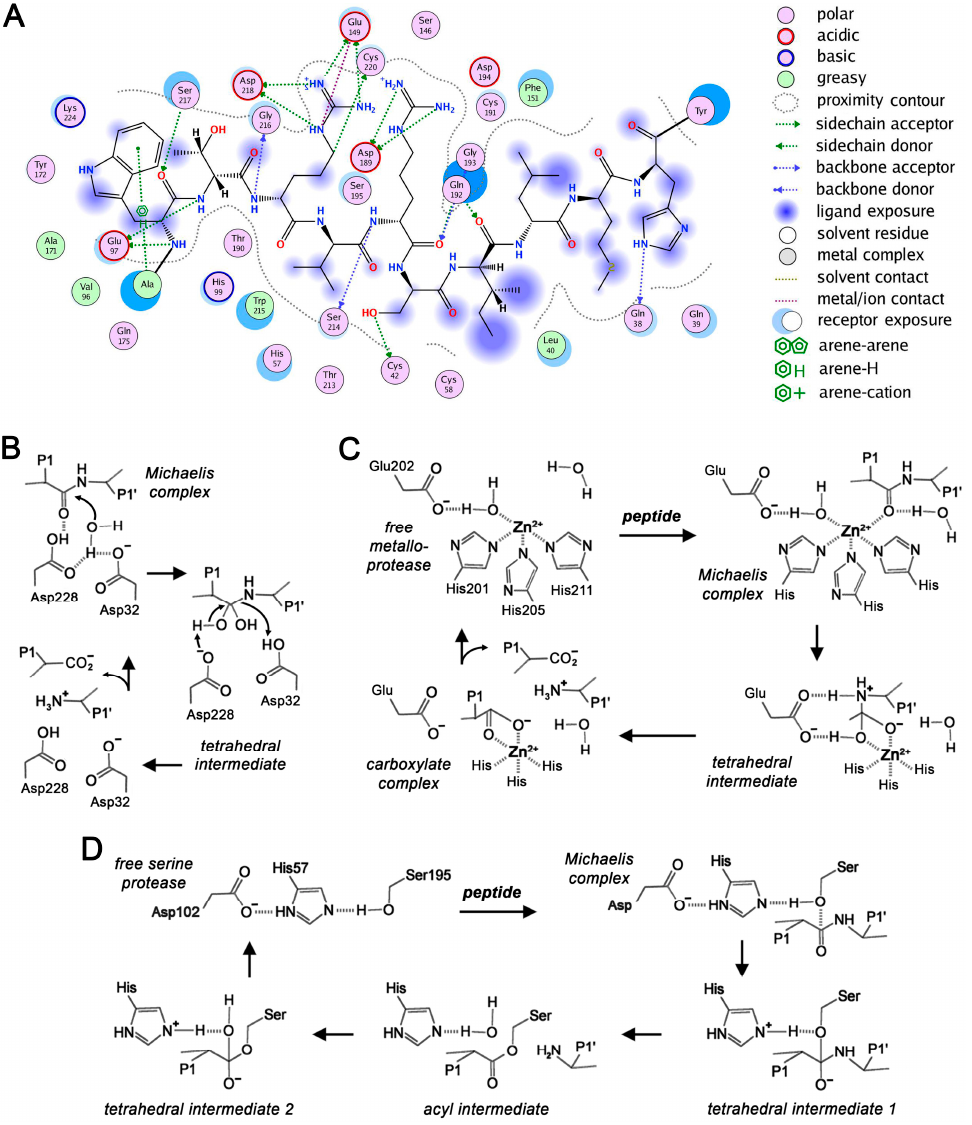
Figure 2. Substrate recognition and catalytic steps in proteases. ( A ) Two-dimensional interaction map of the model peptide AWTRVR-SILMHY with the specificity subsites S6-S6 ′ of a KLK protease, calculated with the MOE software [114]. The tryptic specificity is based on the electrostatic interaction of P1-Arg and Asp189 in the S1 pocket. Chymotryptic proteases prefer hydrophobic P1 side chains, such as Tyr or Phe; ( B ) The aspartic protease mechanism requires a pair of Asp residues, with one being the general base that activates a water molecule as in BACE-1 [115]. After substrate binding, the nucleophilic water attacks the scissile bond between P1 and P1 ′ at the carbonyl C atom; ( C ) Three major metalloprotease mechanisms are known, such as the favored one for MMP-3 [116]; and ( D ) Catalysis of a serine protease with chymotrypsinogen numbering [117]. Other serine protease clans exhibit different arrangements of the triad with similar mechanisms. The catalytic triad activates the Ser O γ as nucleophile via an acid (Asp102) and a general base (His57), which activates a water molecule for hydrolysis of the acyl intermediate [118]. In addition, cysteine protease mechanisms are related, but often require only Cys-His dyads, since the S γ is more nucleophilic than the Ser O γ [119]. Similarly, threonine proteases have a nucleophilic Thr O γ , while the N-terminus and/or a Lys side chain serve as bases [120]. MEROPS lists variations of catalytic residues and rare protease types [45].